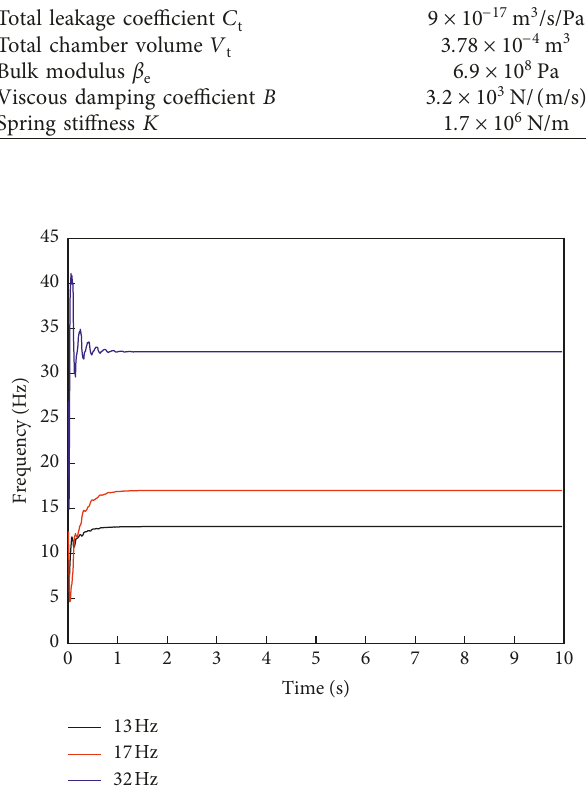
Figure 11: Convergence of estimated frequency parameters.